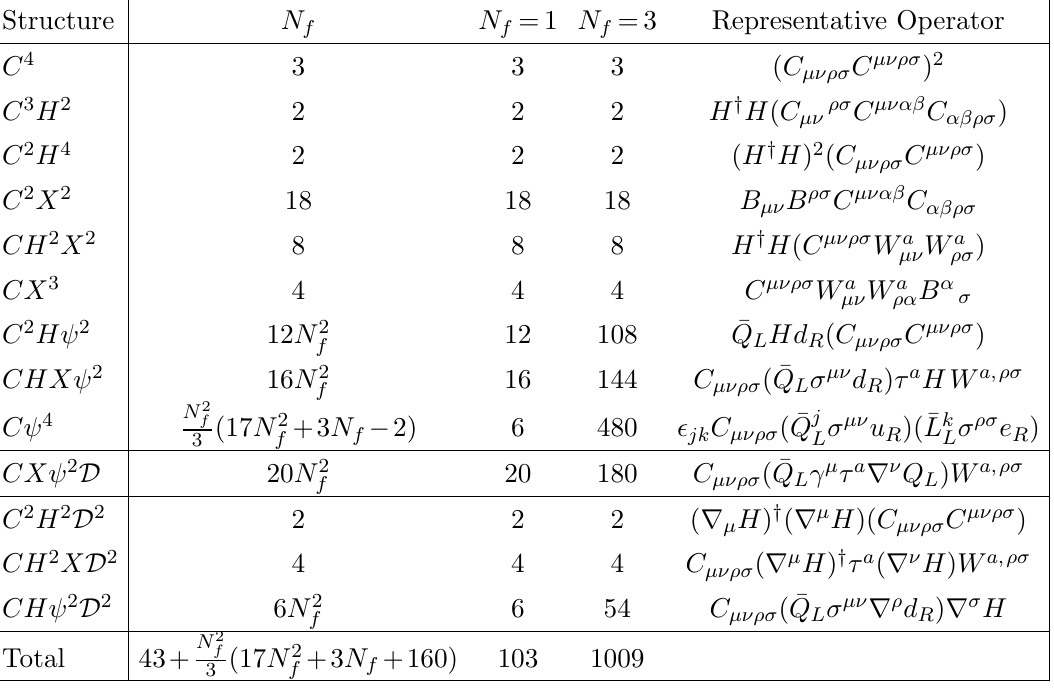
Table 2 . Classi(cid:12)cation of dimension-8 operators containing gravity interactions. C denotes the Weyl tensor, whereas H , , X and D stand for the Higgs, fermions, gauge (cid:12)elds and derivatives respectively. We show the number of operators in each class for N f fermion (cid:13)avors and give one exemplary operator for each